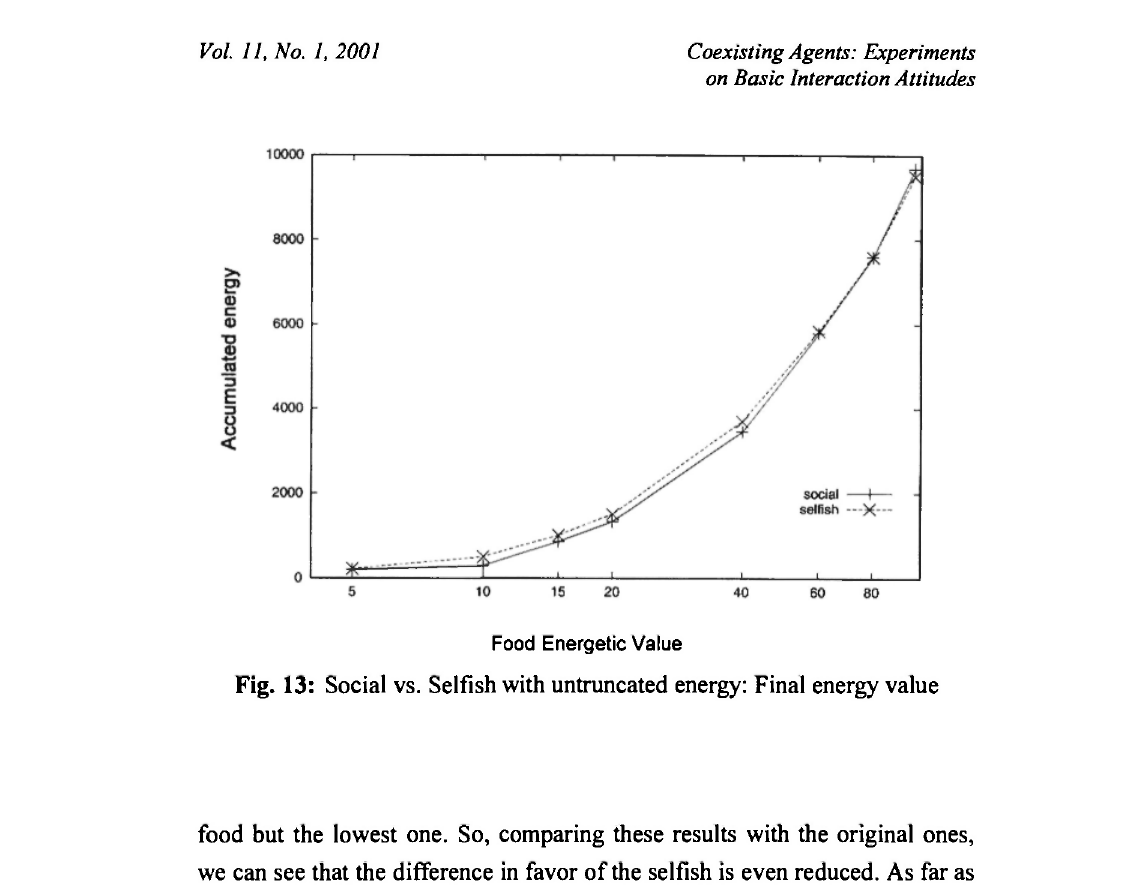
food but the lowest one. So, comparing these results with the original ones, we can see that the difference in favor of the selfish is even reduced. As far as final energy is concerned, results show (Fig. 13) that the two groups per- formed in the same way, showing no difference between each other. Also in terms of standard deviations of final energy, no significant difference was found between social and selfish